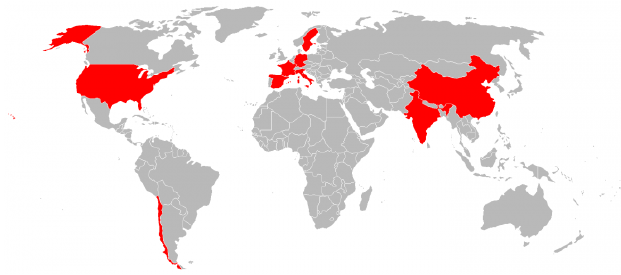
Figure 2. The nine different countries involved in the special issue.